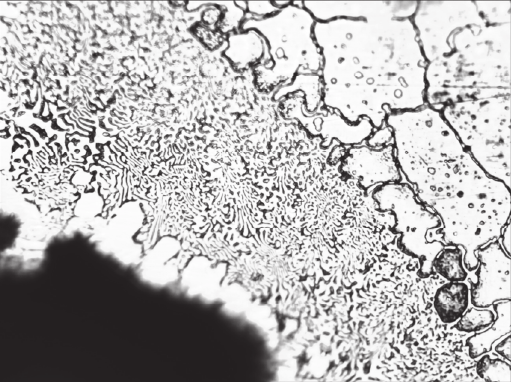
Figure 9: Optical micrograph of the recast layer on HS 6-5-2 steel after electrical discharge treatment in electrolyte at 230 V for 10 min,